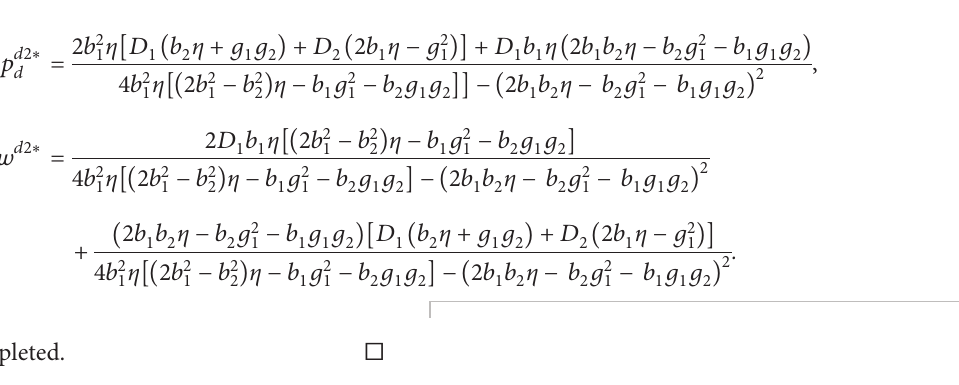
Figure 5: The optimal collection price of the retailer under the centralized and decentralized